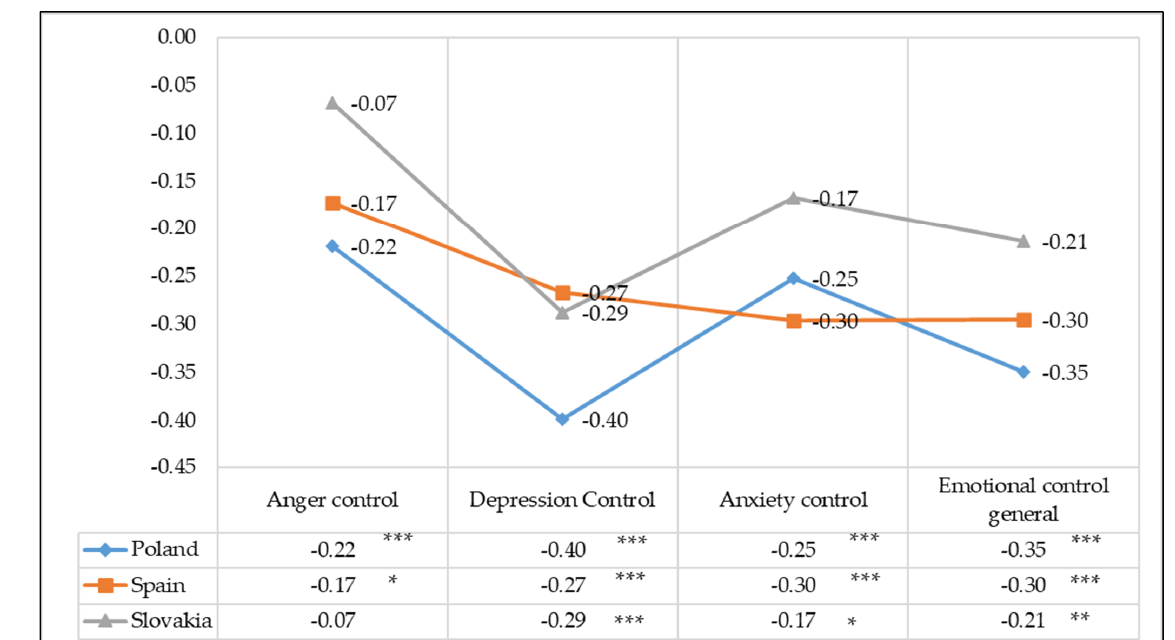
Figure 3. The nature and strength of the correlation between positive orientation and anger, depres- sion and anxiety control in students—Pearson correlation coefficient (r). Statistically significant: * p < 0.05; ** p < 0.01; *** p < 0.001